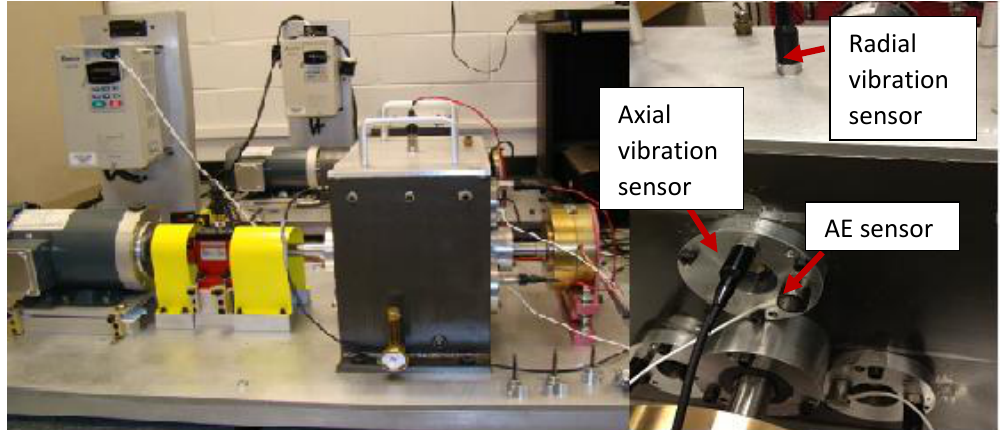
Figure 5. The notational split torque gearbox and sensor locations.